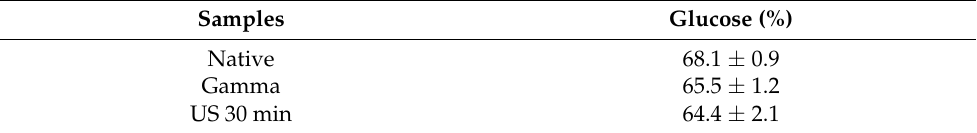
Figure 6. Monosaccharide contents for native and pre-treated flax tows. Table 1. Glucose contents of Native, Gamma and ultrasound pre-treated flax tows.